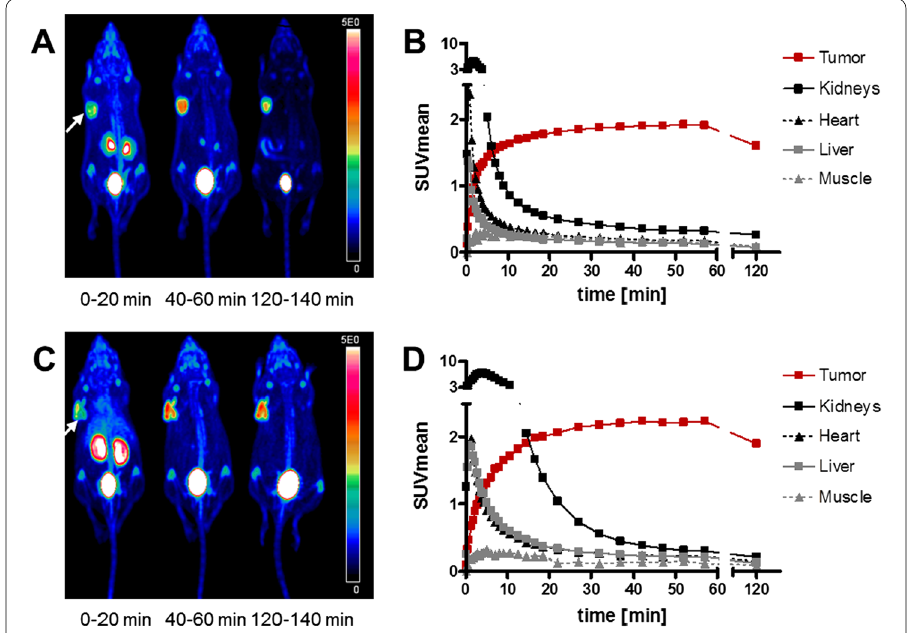
Fig. 2 Small animal PET imaging. The white arrow indicates the site of the xenotransplanted tumor. Shown are the maximum intensity projections ( A , C ) and time‑activity curves ( B , D ) of selected organs in case of [ 18 F] AlF‑FAPI‑74 ( A , B ) and [ 18 F]AlF‑FAPI‑75 ( C , D ). Experiments were conducted in nude mice transplanted with HT‑1080‑FAP cells and images were acquired in the indicated time periods after tracer administration